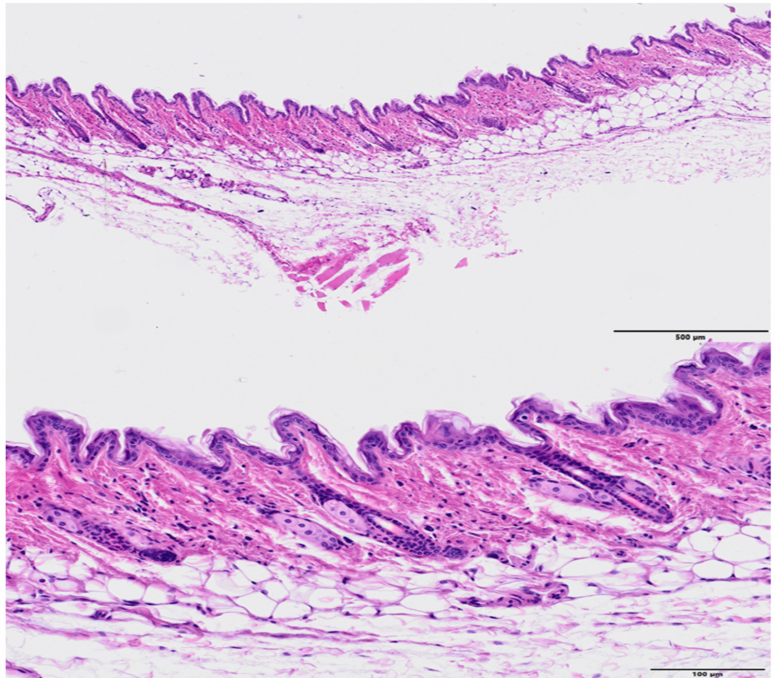
Figure 8. Histology images of a control (non-irradiated leg), HE. Up: no abnormal histopathological findings were observed (bar = 500 µ m). Low: higher magnification (bar = 100 µ m) showing the normal histological cutaneous